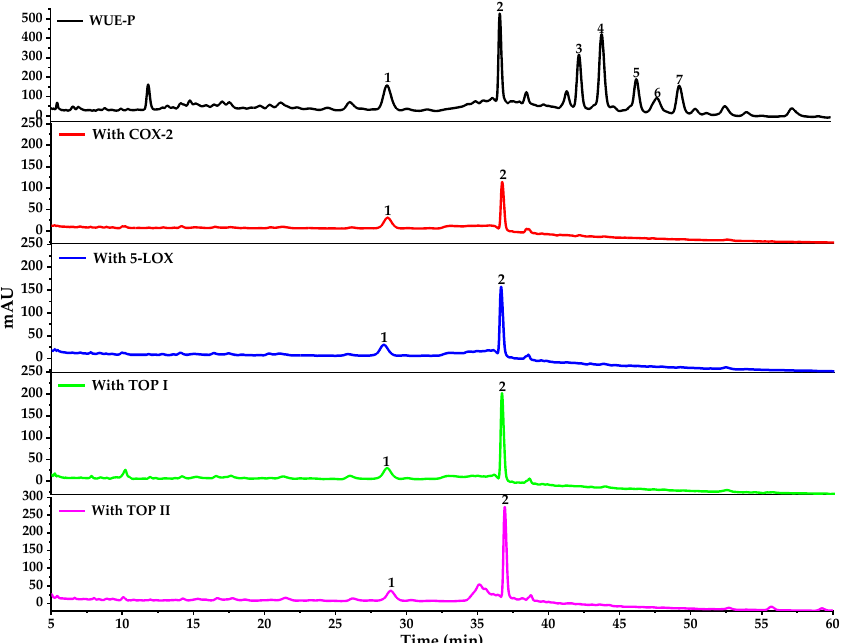
Figure 2. The HPLC-UV chromatograms of components in WE-P from W. ugandensis by ultrafiltration. The black line represents HPLC-UV profiles of WE-P from W. ugandensis without ultrafiltration, the red line represents HPLC-UV profiles of WE-P from W. ugandensis with COX-2, the blue line represents HPLC-UV profiles of WE-P from W. ugandensis with 5-LOX, the green line represents HPLC-UV profiles of WE-P from W. ugandensis with Top I, the purple line represents HPLC-UV profiles of WE-P from W. ugandensis with Top II, respectively.